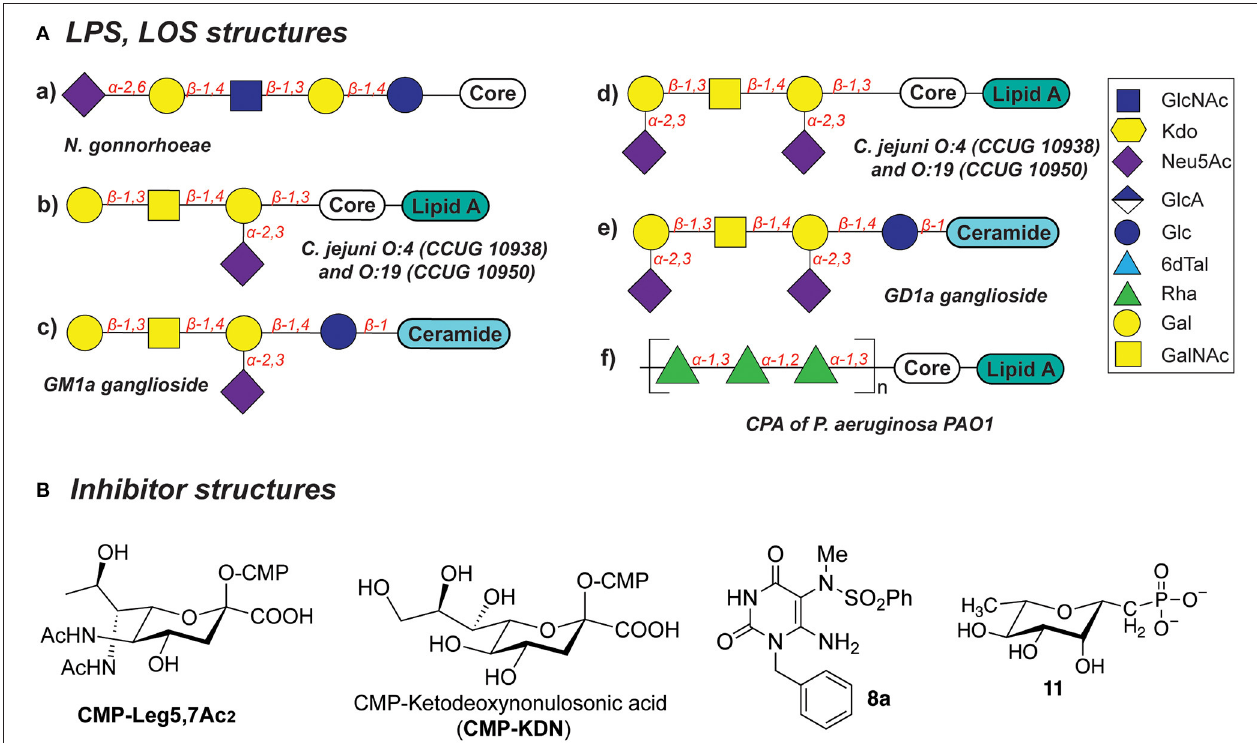
FIGURE 5 | (A) Structures of LOS described in this section. (B) Structures of inhibitors discussed in this section.